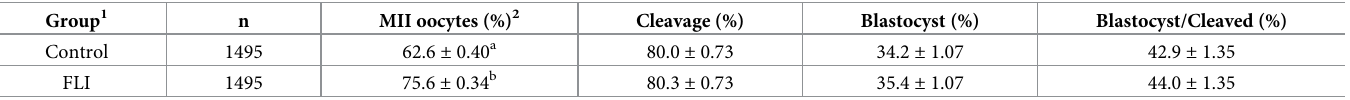
Table 1. In vitro development of bovine embryos supplemented with and without FLI during